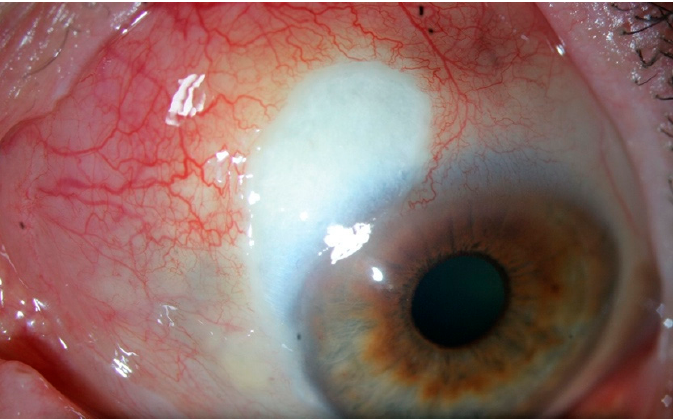
Figure 4. Diffuse anterior scleritis. Widespread inflammation of sclera, and abnormal appearance of the deep scleral vascular plexus. The scleral plexus becomes visible after blanching the superficial vessels with phenylephrine.